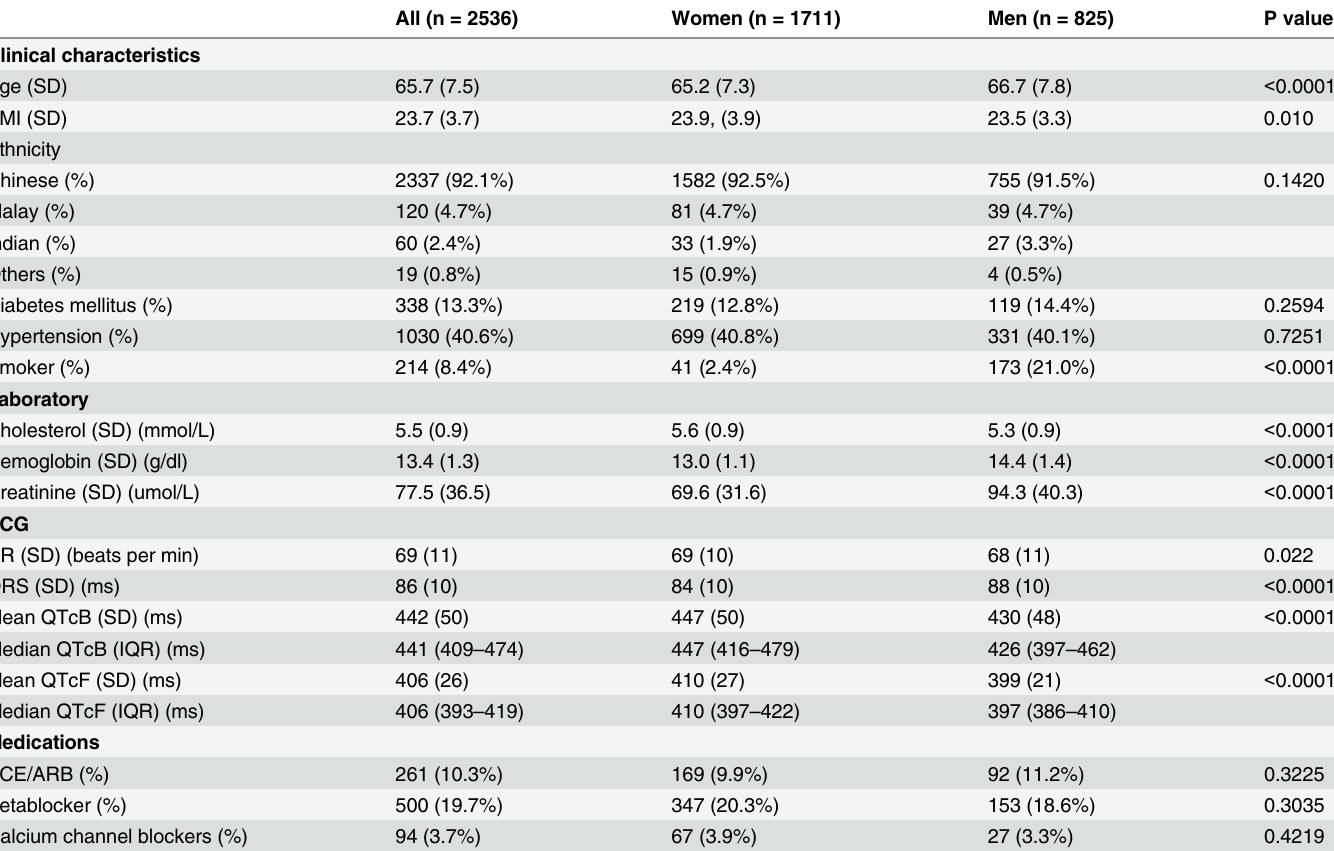
Table 1. Baseline